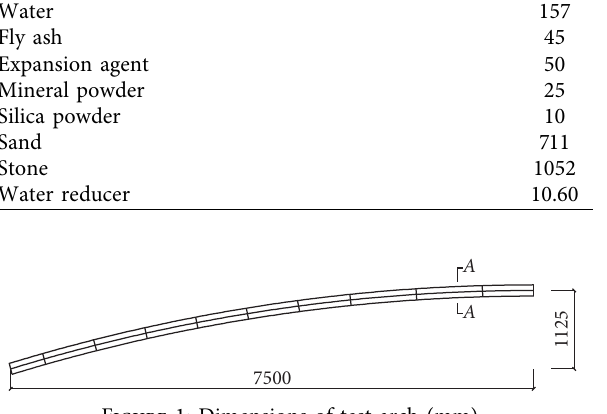
Figure 1: Dimensions of test arch (mm).